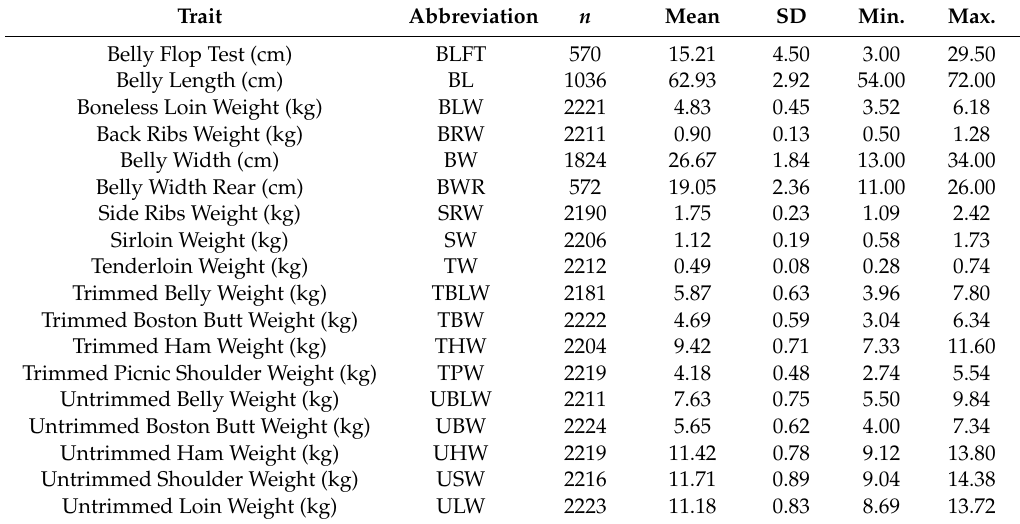
Table 2. Complete descriptive statistics for novel carcass